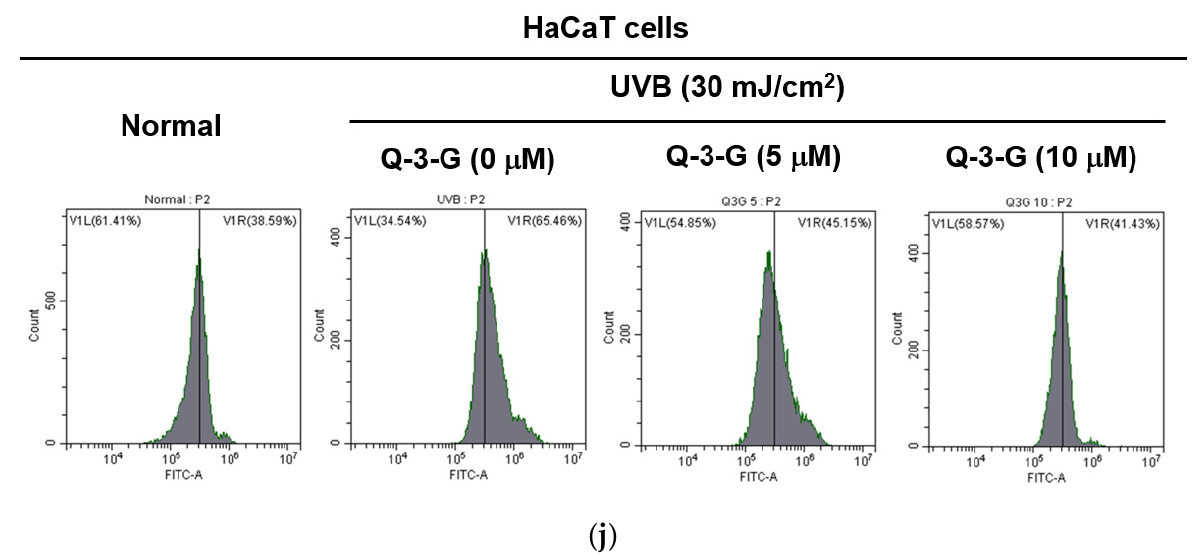
Figure 2. Anti-inflammatory and antioxidant effects of Q-3-G. ( a ) Treatment of HaCaT cells with various concentrations of Q-3-G (0–20 µ M) for 24 h, using a conventional MTT assay to determine cell viability. ( b ) HaCaT cells irradiated with UVB (30 mJ/cm 3 ) for 10 s in the absence or presence of Q-3-G (0–20 µ M), followed by incubation for 24 h. A conventional MTT assay was used to determine cell viability. ( c , d ) HaCaT cells were treated with Q-3-G (5, 10 µ M) and UVB irradiation (30 mJ/cm 3 ) for 24 h. The representative cell morphology of Q-3-G against UVB was observed via microscopy, and the number of cells was then plotted. ( e , f ) Anti-inflammatory effect of Q-3-G in HaCaT cells. The HaCaT cells were irradiated with UVB (30 mJ/cm 3 ) for 10 s or incubated with H 2 O 2 (500 µ M) with or without Q-3-G (5–10 µ M) and further incubated for 12 h. The mRNA expression levels of COX-2 ( e ) and TNF- α ( f ) were determined by quantitative real-time PCR. GAPDH was used as a housekeeping gene. ( g – j ) Antioxidant effect of Q-3-G in HaCaT cells. Q-3-G (0–40 µ M) was reacted with 2,2-diphenylpicrylhydrazyl (DPPH) in the dark at 37 ◦ C for 30 min. The absorbance at 517 nm was measured spectrophotometrically ( g ). Q-3-G was reacted with 2,2-azinobis-(3-ethylbenzothiazoline-6-sulfonic acid (ABTS) at different concentrations in the dark at 37 ◦ C for 30 min. The absorbance at 730 nm was measured spectrophotometrically ( h ). Ascorbic acid was used as a control substance. ( i ) The HaCaT cells were irradiated with UVB (30 mJ/cm 3 ) for 10 s with or without Q-3-G (5–10 µ M) and after incubating for 12 h, the mRNA level of Nrf2 was determined by quantitative real-time PCR. GAPDH was used as a housekeeping gene. ( j ) The representative result of intracellular ROS production was measured by flow cytometry using DCFDA staining in HaCaT cells with or without UVB irradiation (30 mJ/cm 3 ) and Q-3-G (0-10 µ M) were treated for 24 h. Results ( a , b , d – i ) are expressed as mean ± SD. # p < 0.05 and ## p < 0.01 compared to normal group (no treatment), and * p < 0.05 and ** p < 0.01 compared to inducer alone (UVB, H 2 O 2 , DPPH, or ABTS).